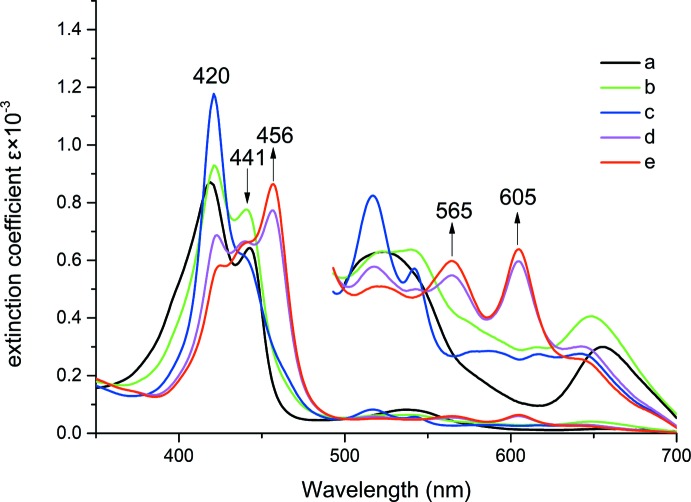
Selected UV–vis spectra taken in tetra­hydro­furan under argon. (a) [FeII(TpClPP)] (6.0 × 10 −5 mol L−1); (b) [FeII(TpClPP)] in 2.4 × 10 −5 mol L−1 [K(222)(CN)] solution; (c) [FeII(TpClPP)] in 6.0 × 10 −5 mol L−1 [K(222)(CN)] solution; (d) [FeII(TpClPP)] in 8.4×10 −5 mol L−1 [K(222)(CN)] solution; (e) [FeII(TpClPP)] in 1.2 × 10 −4mol L−1 [K(222)(CN)] solution. The enlarged spectra from 500 to 750 nm were measured in a 10 mm UV cell.